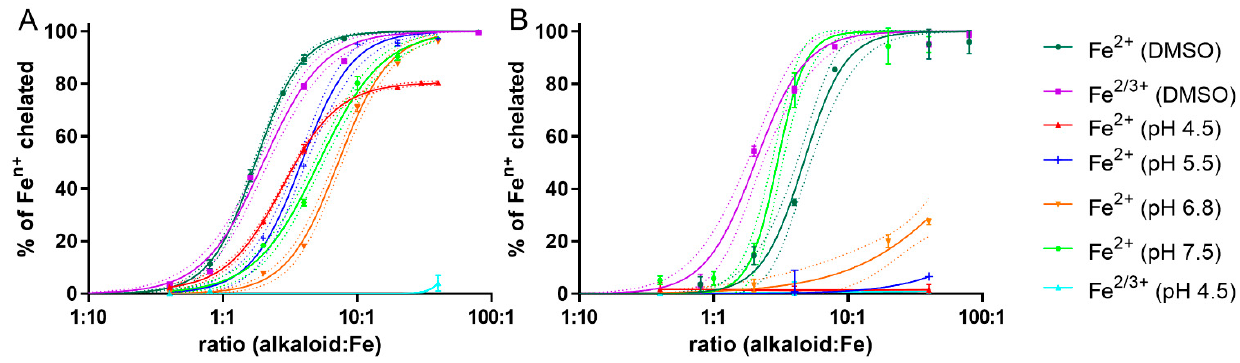
Figure 2. Iron-chelation activity of galanthine ( A ) and glaucine ( B ) under different conditions.